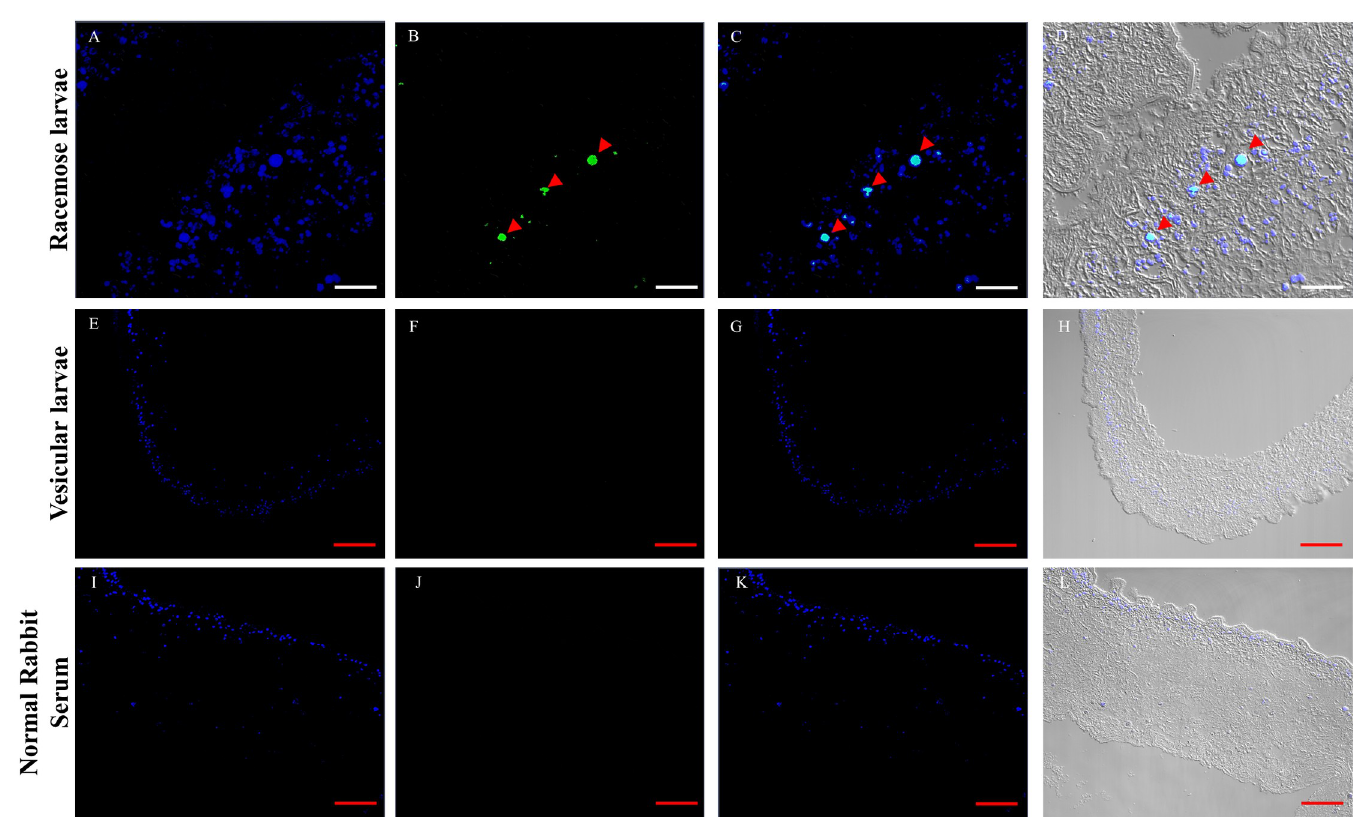
Fig 4. In situ identification of mitotic cells in Taenia solium cyst samples by IF. IF assays performed on racemose and vesicular larvae. The nuclei were stained with DAPI (A,E,I), positive cells to phospho histone H3 (arrowheads) were observed only in racemose larvae (B), merge (C,G,K), merge + brightfield (D,H,L). Sample of racemose larvae was incubated with normal rabbit serum and used as a control. Images captured with a 20X objective; racemose larvae: zoom 3, vesicular larvae and control: zoom 1.White scale bar: 20 μ m; red scale bar: 50 μ m. https://doi.org/10.1371/journal.pntd.0009303.g004 the human β -actin gene. After performing electrophoresis to visualize the amplification prod- uct, we observed that the parasite cell cultures are free of host cell contamination (Fig 8B). The doubling times of cells isolated from racemose and T . crassiceps larval cysts were 113 h and 79 h, respectively. The stationary phase of the growth curve was not reached in racemose